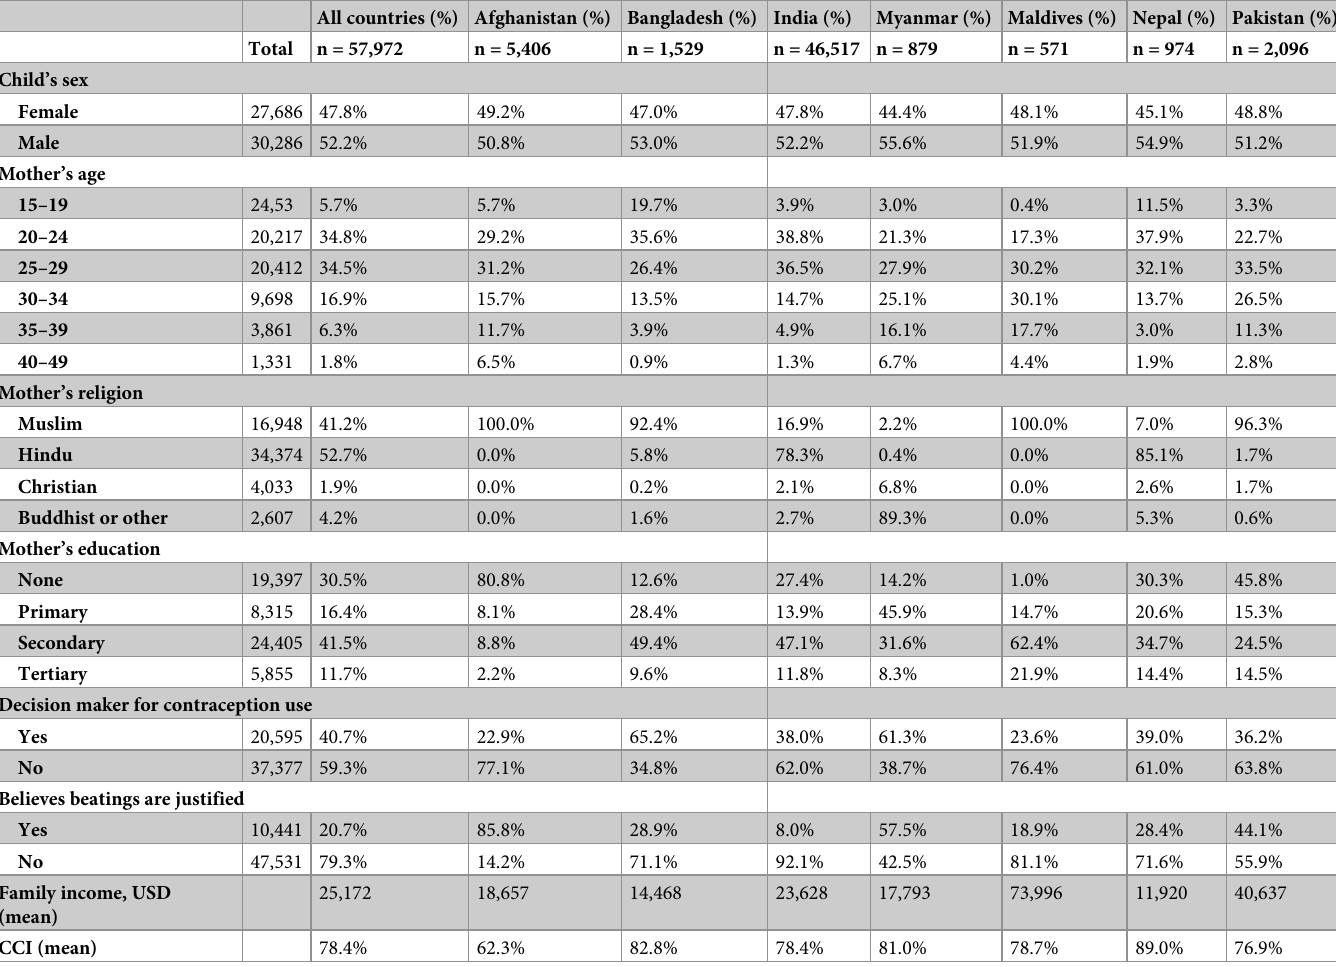
Table 2. Distribution of demographic and autonomy characteristics across 7 South Asian countries, among mothers of children 12–23 months